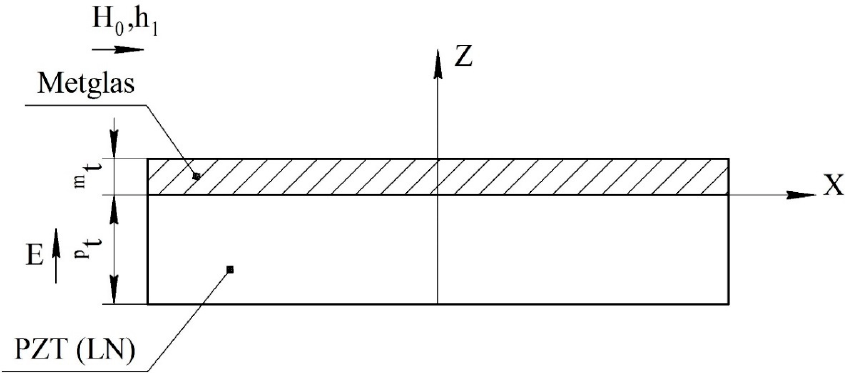
Figure 4. Asymmetrical two-layer magnetoelectric composite for calculation of longitudinal and bending modes. All designations are the same as in Figure 1.